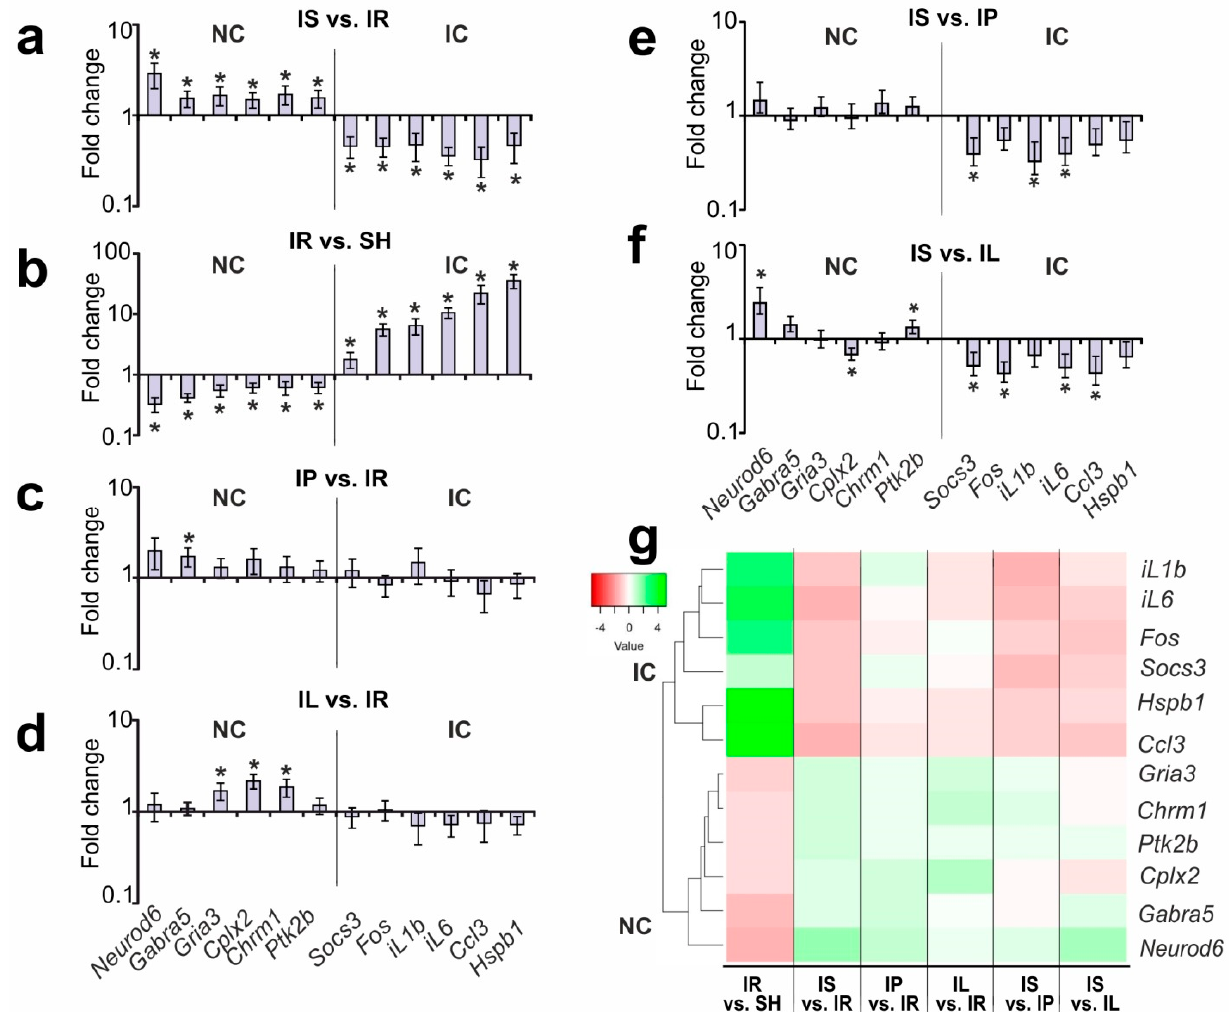
Figure 2. RT-PCR analysis of DEGs and discrimination of peptides’ effects under IR conditions (24 h after tMCAO). ( a – f ) Analysis of the changes in the gene expression of IC and NC clusters in IS versus IR ( a ), IR versus SH ( b ), IP versus IR ( c ), IL versus IR ( d ), IS versus IP ( e ), and IS versus IL ( f ). The data are presented as the means ± standard errors of the means (SEs). The statistical significance ( p < 0.05) is indicated above the bars by an asterisk (*). ( g ) Hierarchical cluster analysis of gene expression profiles obtained in different pairwise comparisons. Each column represents a comparison group, and each row represents a DEG. Green strips represent high relative expression, and red strips represent low relative expression, with at least eight per group.